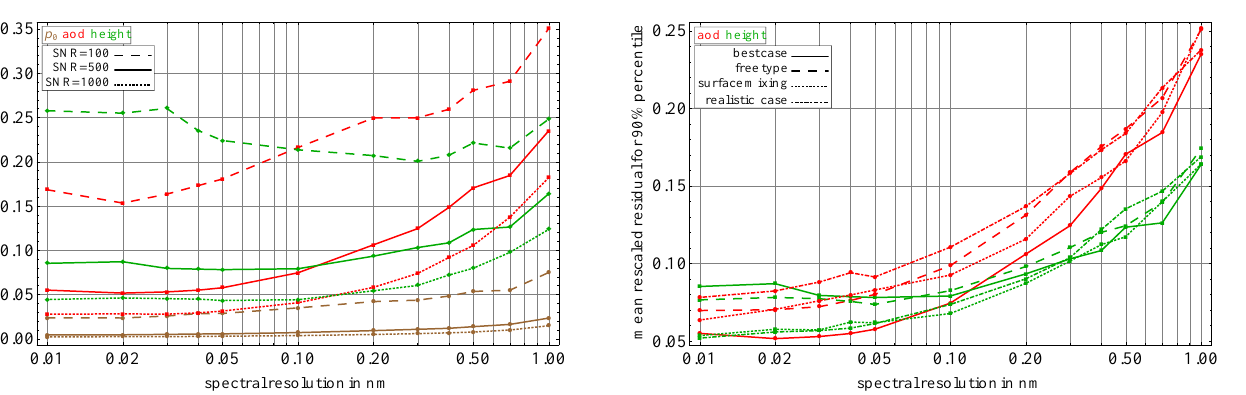
Figure 12. Similar to Fig. 11 but only for aerosol optical thickness and aerosol height, but with respect to aerosol type information and surface inhomogeneity. Shown are the best case and the realistic case scenario and also the free type scenario where the aerosol type is unknown to the retrieval but the surface is homogeneous and also the surface mixing scenario where the aerosol type information is given but the surface is assumed to be inhomogeneous.